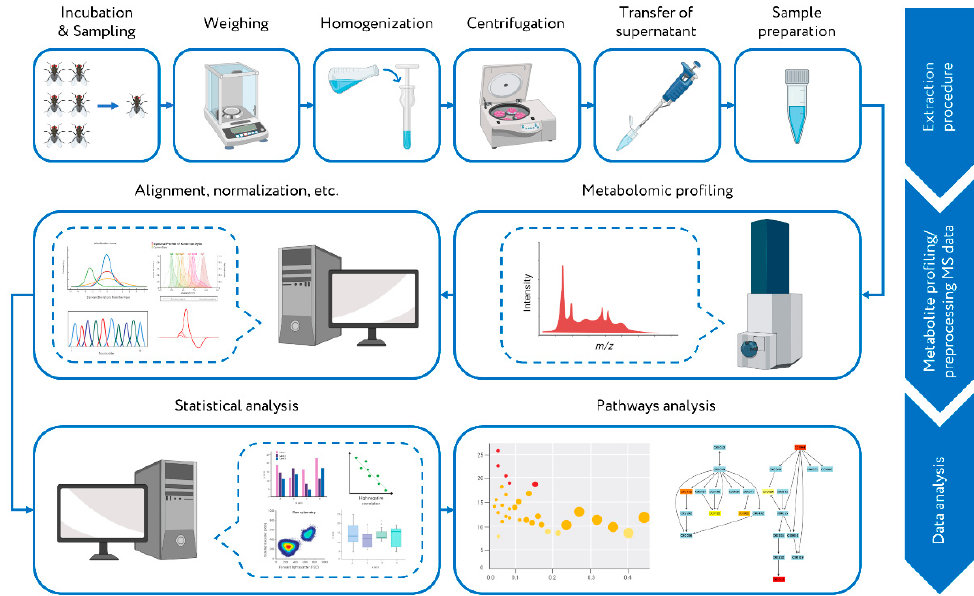
Figure 1. Workflow of the metabolomics study of fly species with different lifespans. Twelve different Drosophila species were cultivated in the fly incubator. Sampling was carried out every 2–6 days. The collected samples (whole adult fly samples) were divided into three biological replicates, weighed, and homogenized (methanol:water 4:1). After centrifugation, the supernatant was submitted to metabolite profiling by high-resolution direct mass spectrometry (MS). The data processing of